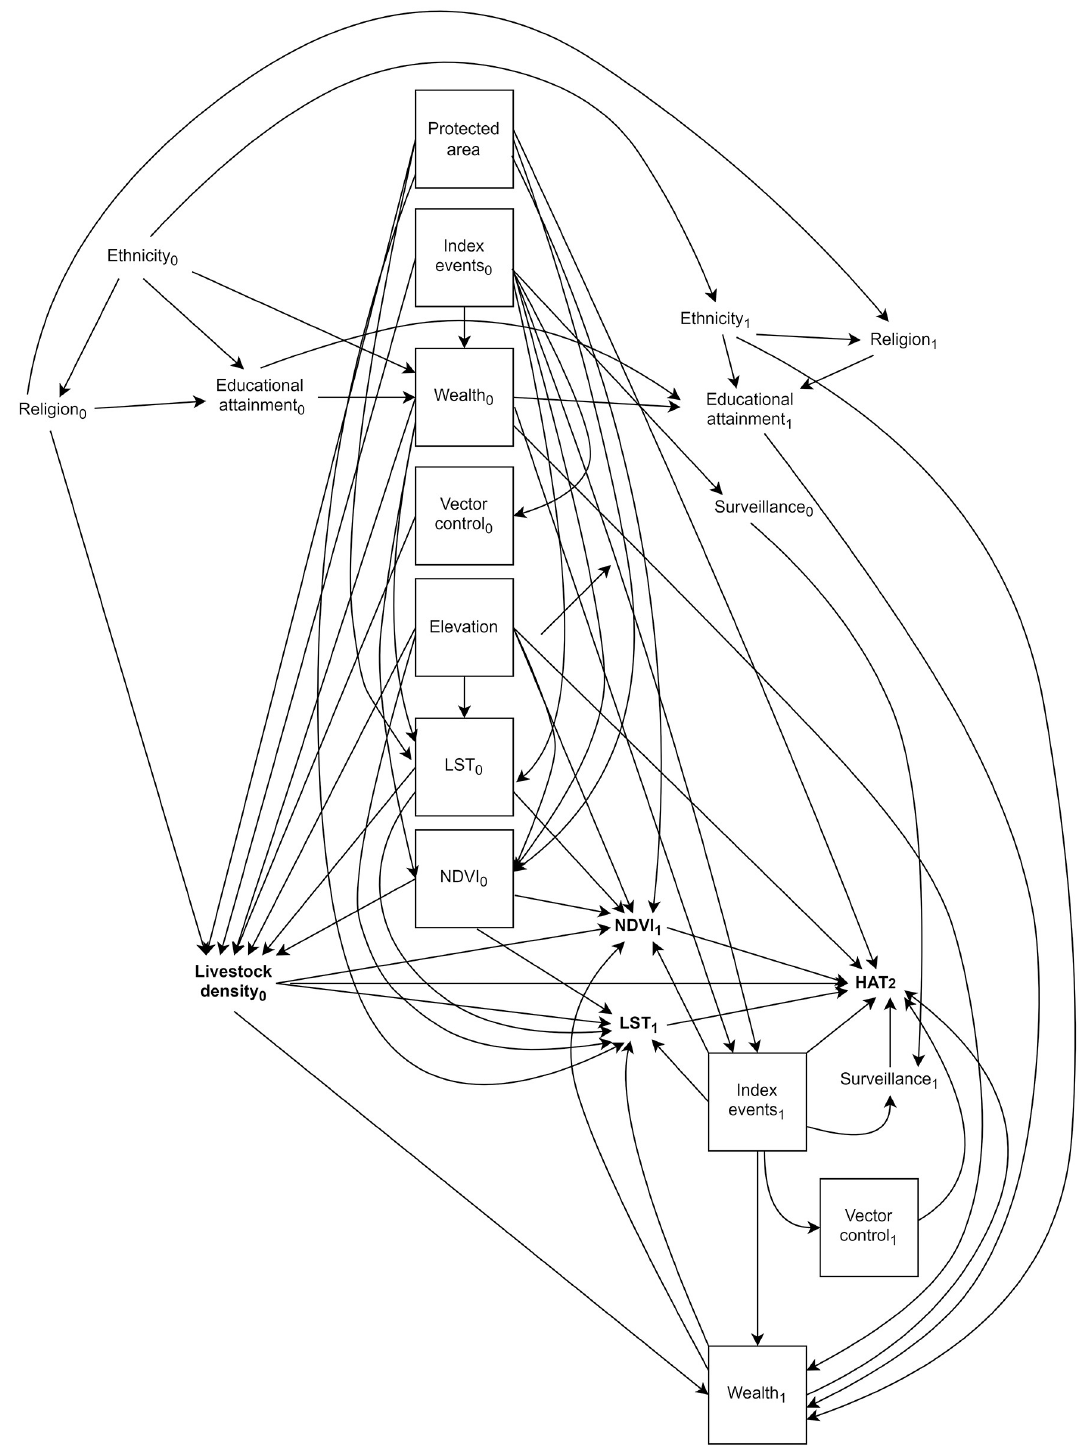
Fig 3. Final time-varying directed acyclic graph (DAG). Protected areas pertains to rHAT models only. Exposure and outcome of interest are bolded, and confounders in the minimally-sufficient set are denoted by solid boxes. HAT 1 and HAT 2 refer to HAT risk at two time